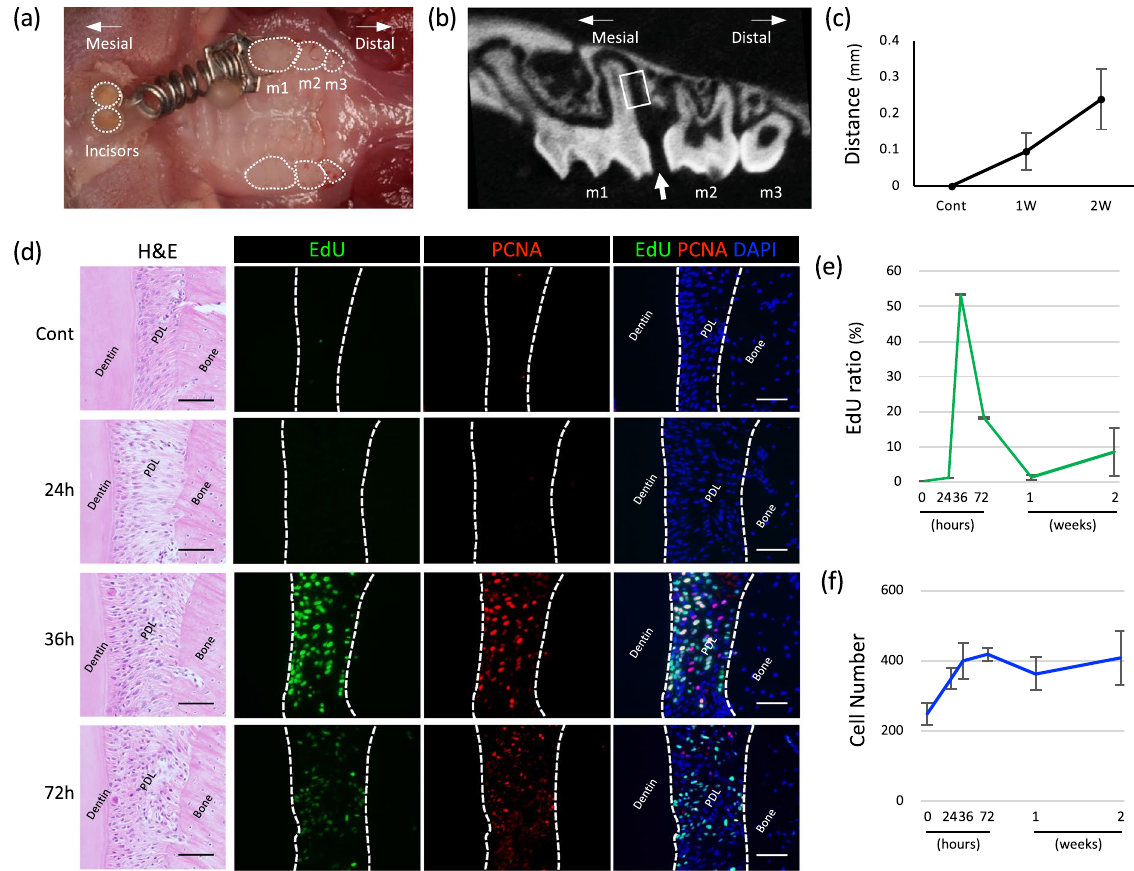
Figure 1. Distribution of proliferating cells in the PDL during OTM. ( a ) OTM of mouse molar. An Ni–Ti coil was placed between the maxillary bilateral incisors and the left first molar of 8-week-old male mice. ( b ) Micro-CT image of maxilla at 2 weeks of OTM. Widening of the distance between the first and second molar was evident (arrow). Distal side PDL of the distal root was chosen as the region of interest (white rectangle). ( c ) Distance between the first and second molars increased over time. ( d ) H&E staining of the histology sample from the distal side PDL of the distal root. Extension of the PDL fibers was evident after 24 h and persisted for up to 72 h. Both EdU + cells (green) and PCNA + cells (red) appeared at 36 h of OTM. The proliferating cells were distributed evenly in the PDL. Bar: 50 μm. ( e ) The EdU + cells exponentially increased at 36 h of